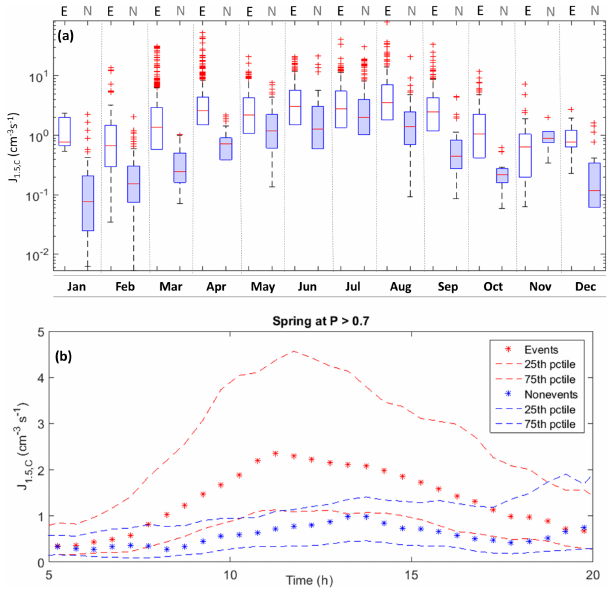
Figure 8. (a) Monthly variation of medians and percentiles of J 1 . 5 ,C during the time window 09:00–12:00 of NPF events (E, white) and nonevents (N, shaded). See Fig. 1 for explanation of symbols. (b) The diurnal cycle of J 1 . 5 ,C during spring. Nighttime is missing in this plot due to unavailable SA proxy which uses UVB to be calculated.